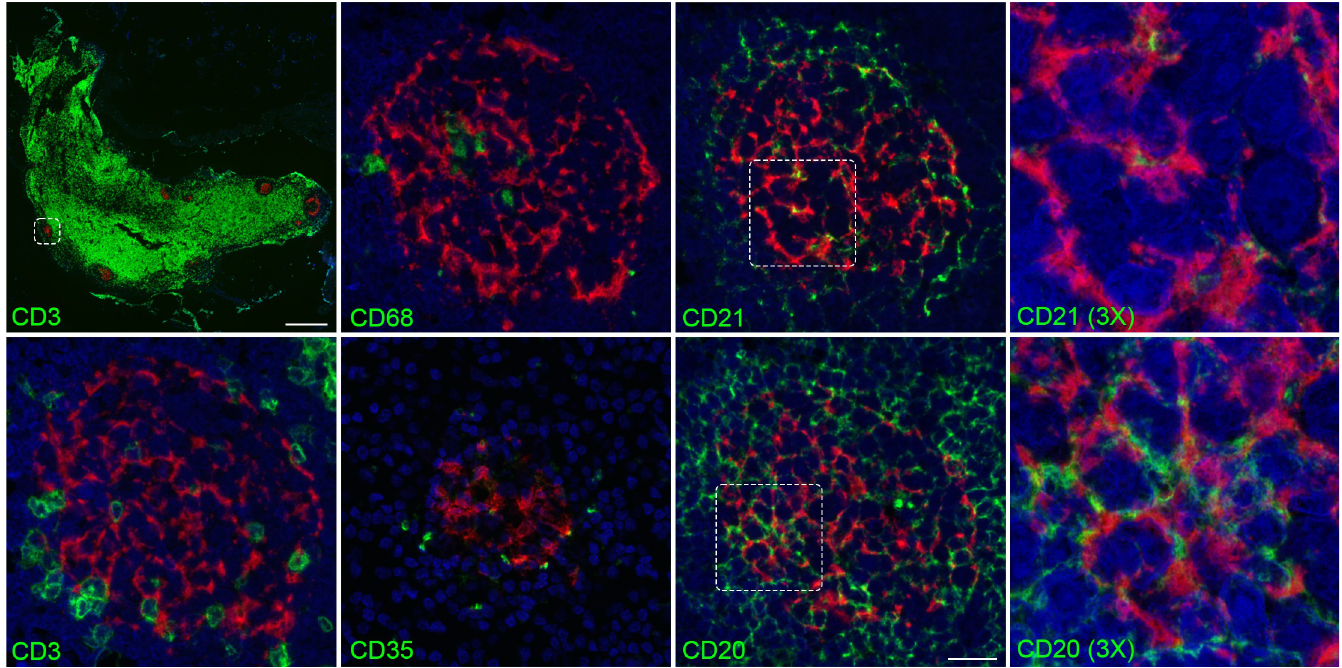
Fig 6. Mesenteric lymph node double staining with KFDV and CD3, CD20, CD21, CD35, or CD68. Mesenteric lymph node sections from an animal infected sc/iv with KFDV was subjected to RNAscope and IHC for CD3, CD20, CD68, CD21, and CD35 using the RNAscope VS Universal ISH-IHC HRP fluorescent assay. KFDV (red) and cell markers (green). Scale bar for low-magnification CD3/KFDV panel, 500 μ m; for high-magnification images of CD3, CD20, CD68, CD21, and CD35, 20 μ m.